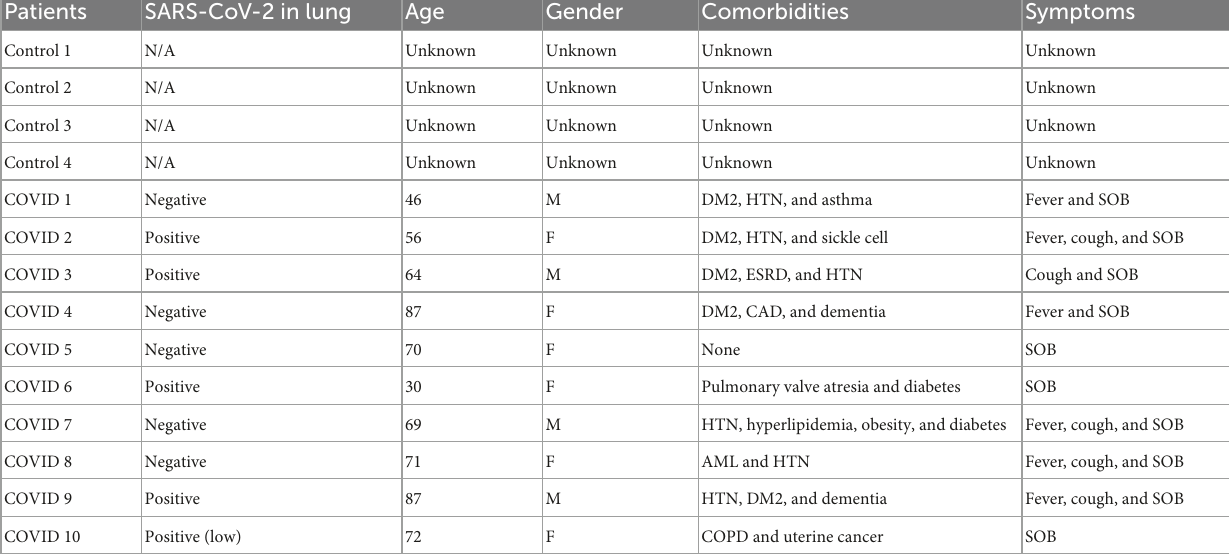
TABLE 2 Main clinical data of